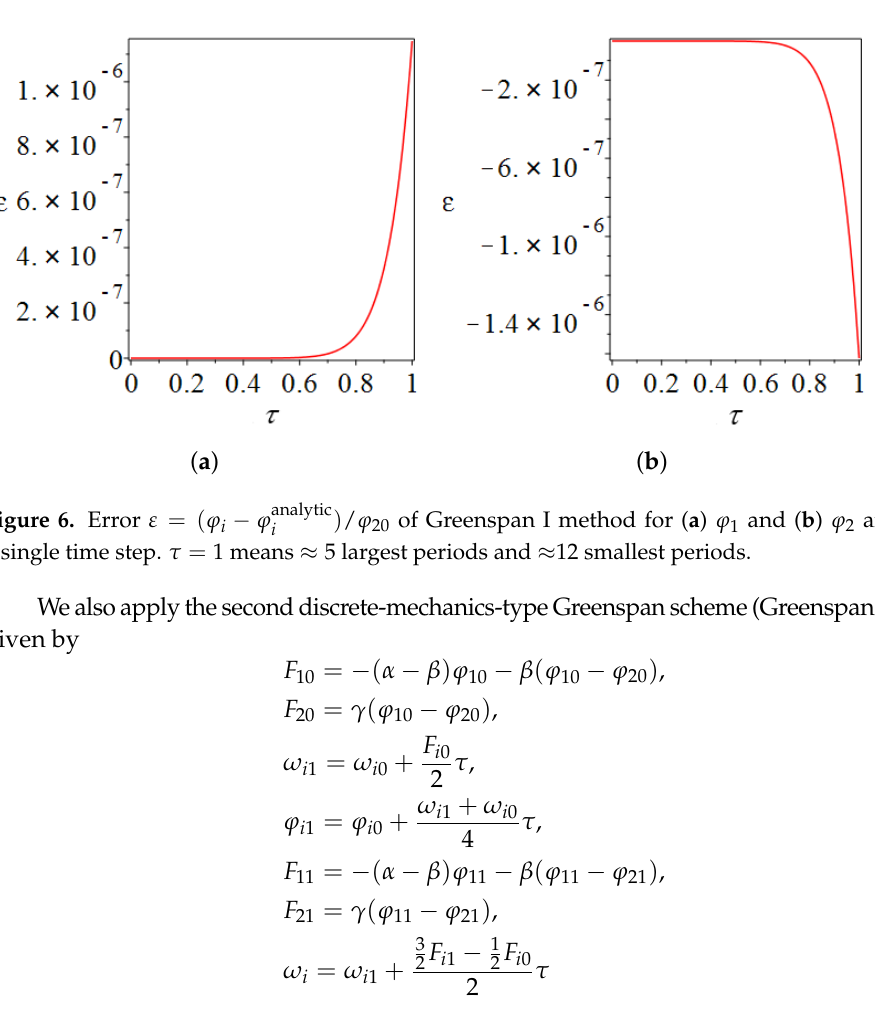
Figure 5. Scheme of double pendulum.